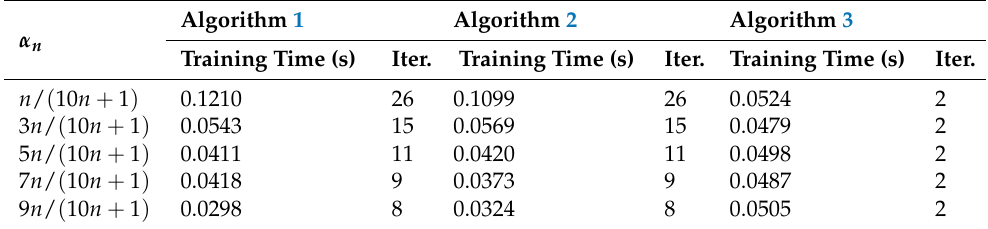
Table 4. Numerical results of different parameters α n .